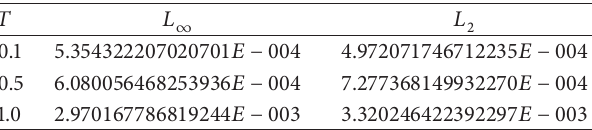
Table 3: Error norms at different time stages for equation 𝑢 𝑡 + 6𝑢 2 𝑢